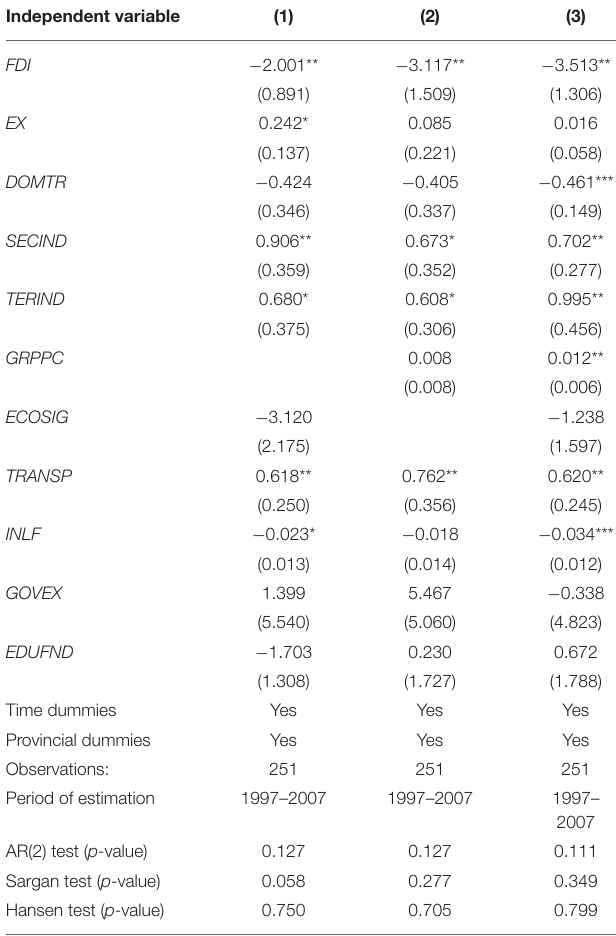
TABLE 3 | Robustness tests for regional inequality and